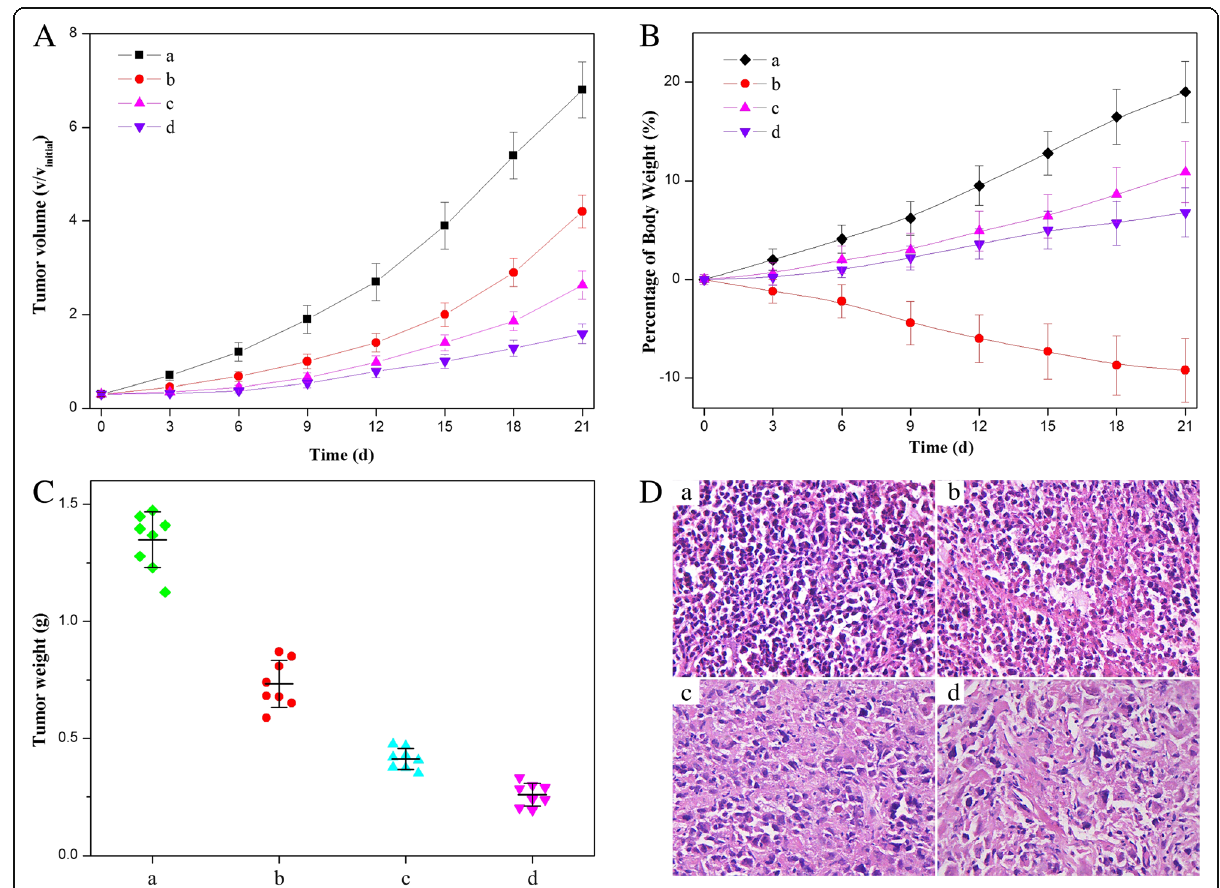
Fig. 12 Anticancer effects of different (nano)formulations. a Volume change of tumor in mice during the treatment. b Weight change of the tumor-bearing mice during the treatment. c Weights of HeLa tumors after being treated by different formulations. d Histological section of the tumor of the mice after the treatment. ( a ) 0.9% NaCl aqueous solution, ( b ) free HCPT, ( c ) NDs, and ( d ) HFNDs. All formulations used the same concentration of HCPT in mice-bearing HeLa tumor. P <